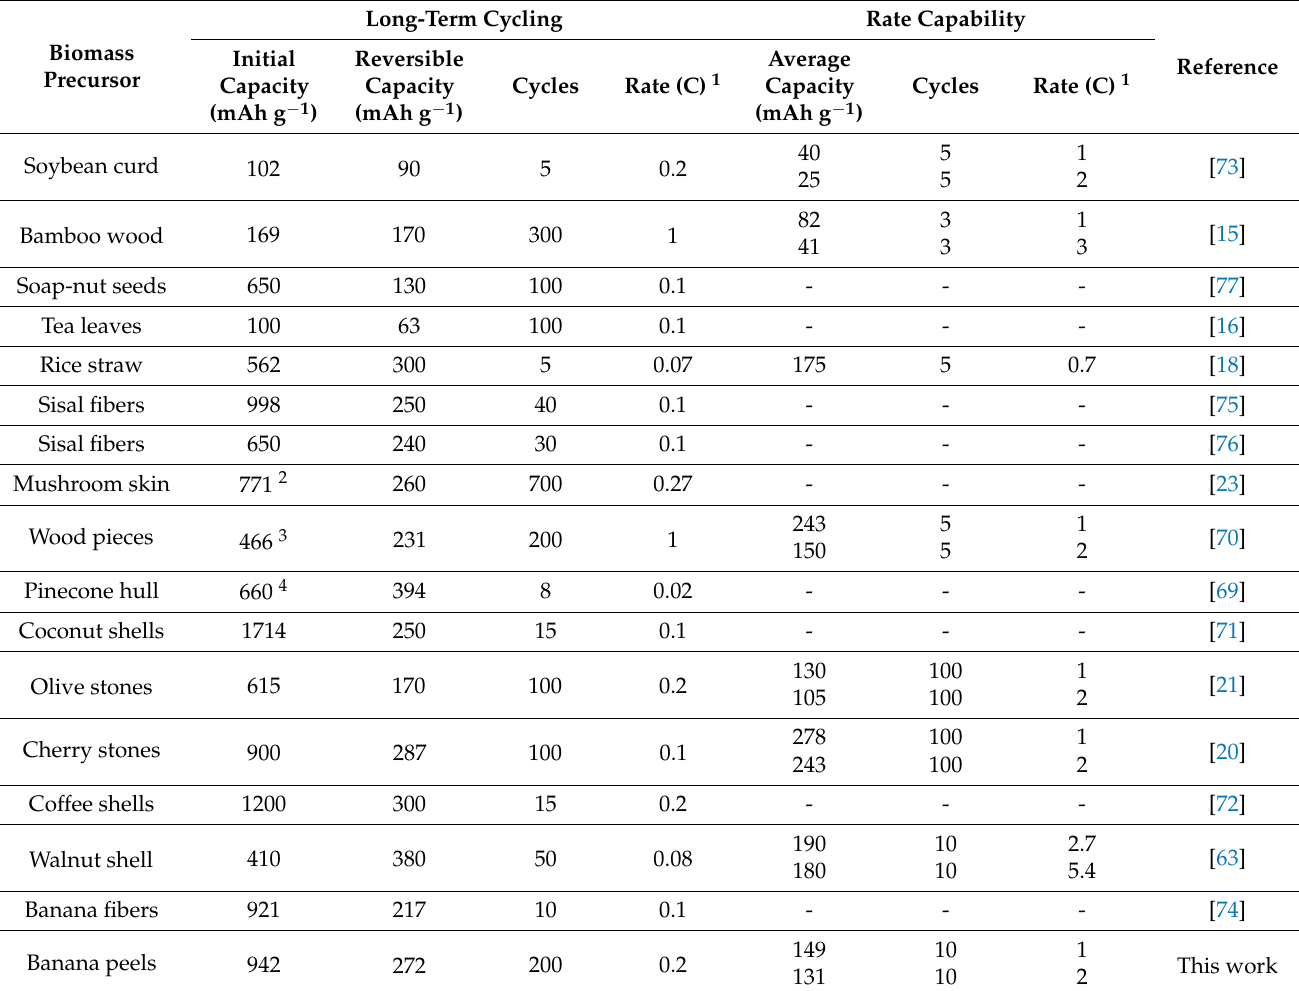
Table 2. Comparison of electrochemical performance of BPW@H 3 PO 4 electrode with other biomass-derived carbonaceous materials reported in the